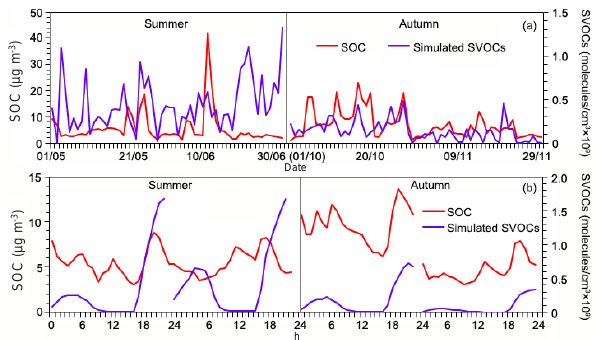
Figure 12. Correlations between calculated SOC and simulated SVOCs in (a) day-to-day variation and (b) diurnal